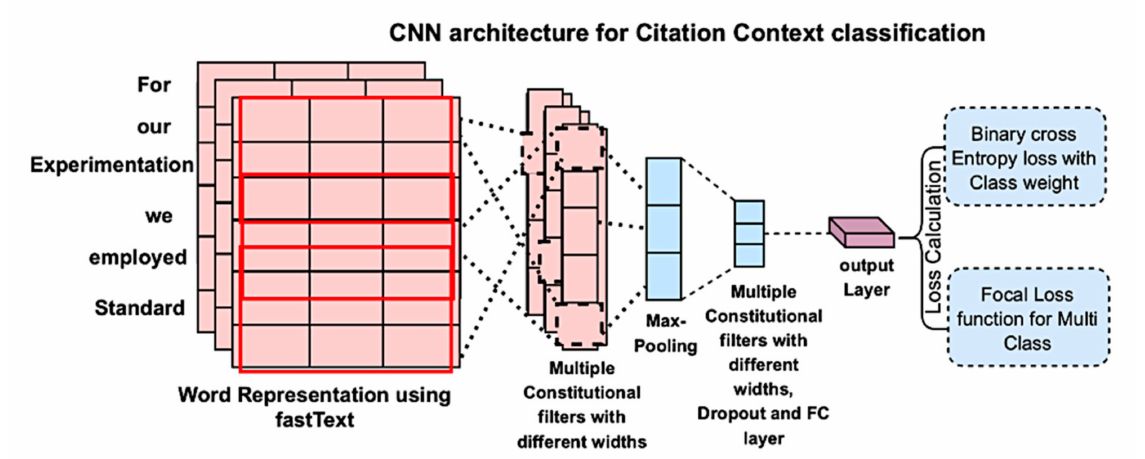
Figure 1. Model architecture for citation context classification with added loss-calculation